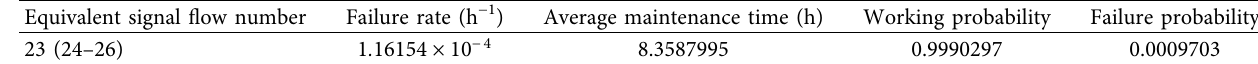
Table 7: Reliability parameters of operators 23 (24–26).